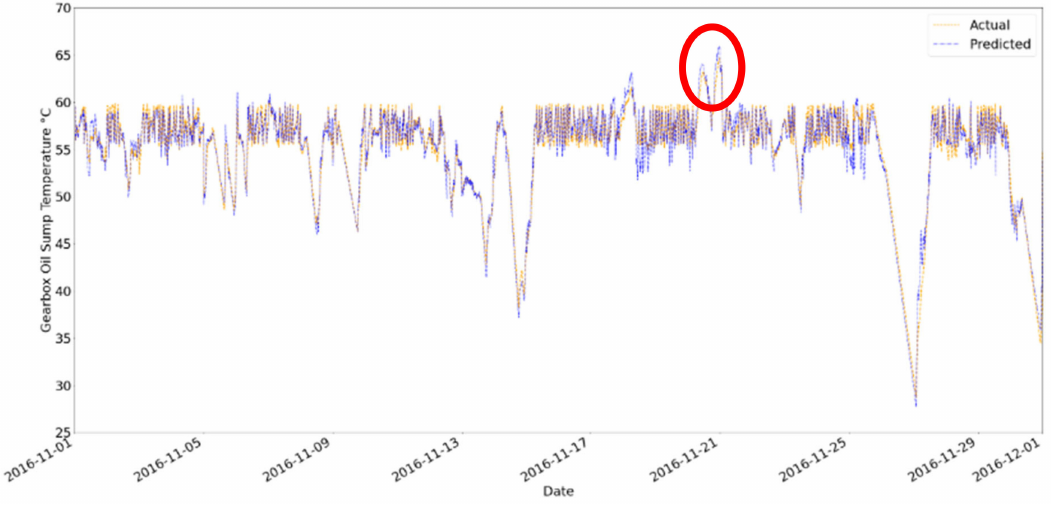
Figure 21. Predicted and Actual Gearbox Oil Sump Temperatures in R80790 WT vs. Date [November 2016 to December